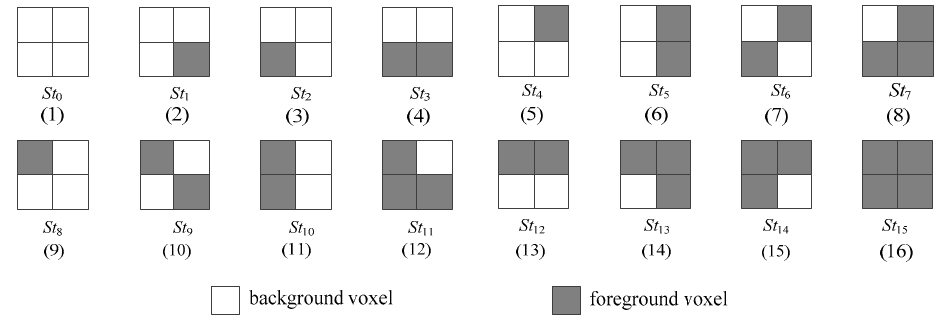
Figure 5. Sixteen states de fi ned in the strategy of state transition.